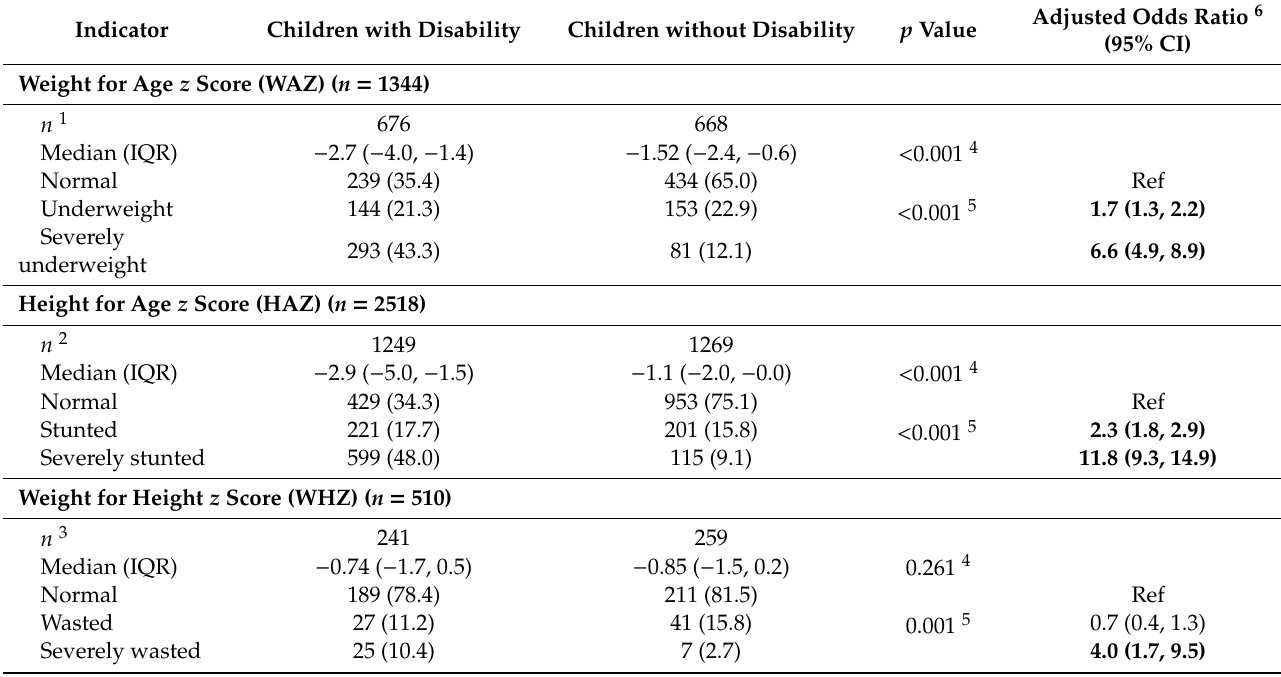
Table 3. Overall nutritional status of study